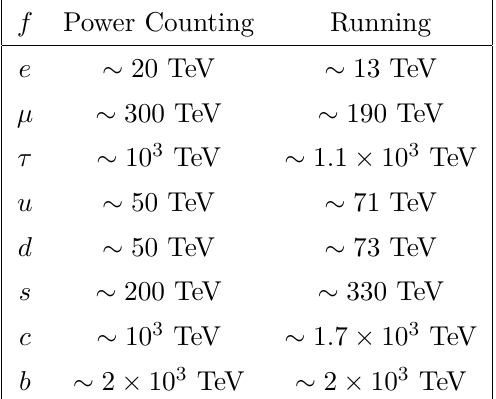
Figure 2 . Representative diagrams allowing two-loop mixing of vector operators to the dipole. f